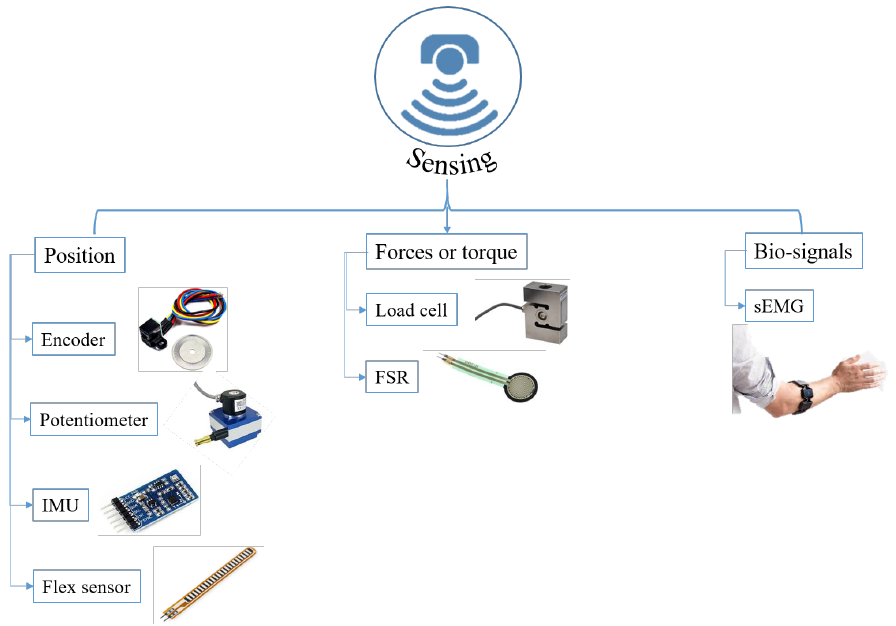
Figure 23. Different sensing adopted in different